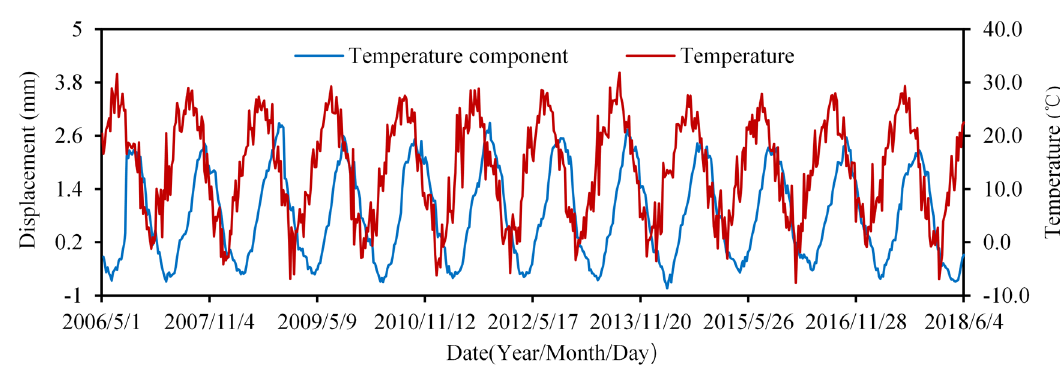
Figure 13. Contributions of water level, temperature and time to the radial displacement.